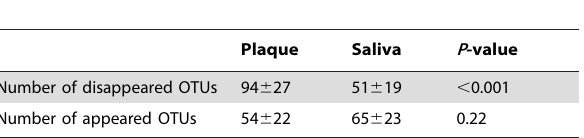
Table 4. Number of operational taxonomic units (OTUs) that either disappeared from or appeared in the microbiota of each subject after periodontal